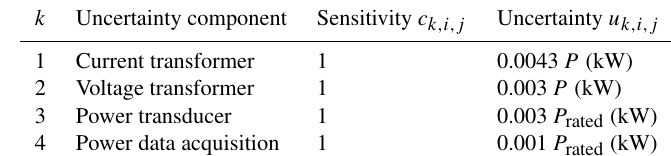
Table 2. Type B uncertainties of the measured power P µ (values as suggested by IEC 61400-12-1).